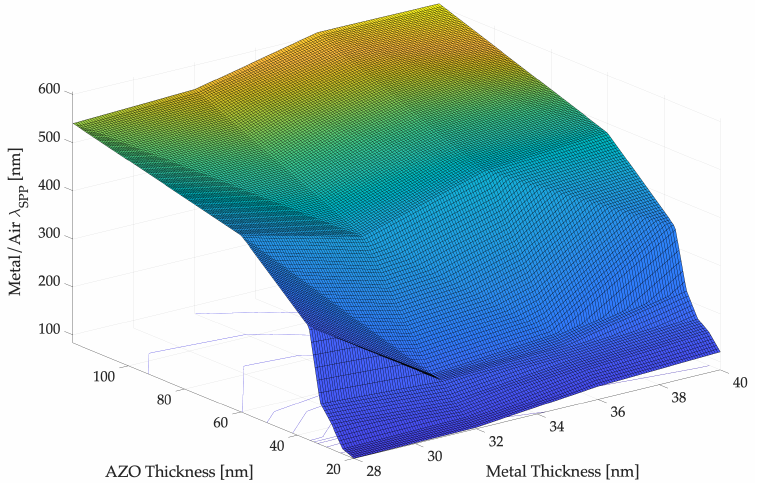
Figure 5. The plasmon’s wavelength, λ SPP for different thicknesses values of metal and AZO at the inter- face AZO/METAL ( up ) and METAL/DIELECTRIC ( down ) obtained by means of COMSOL simulations.